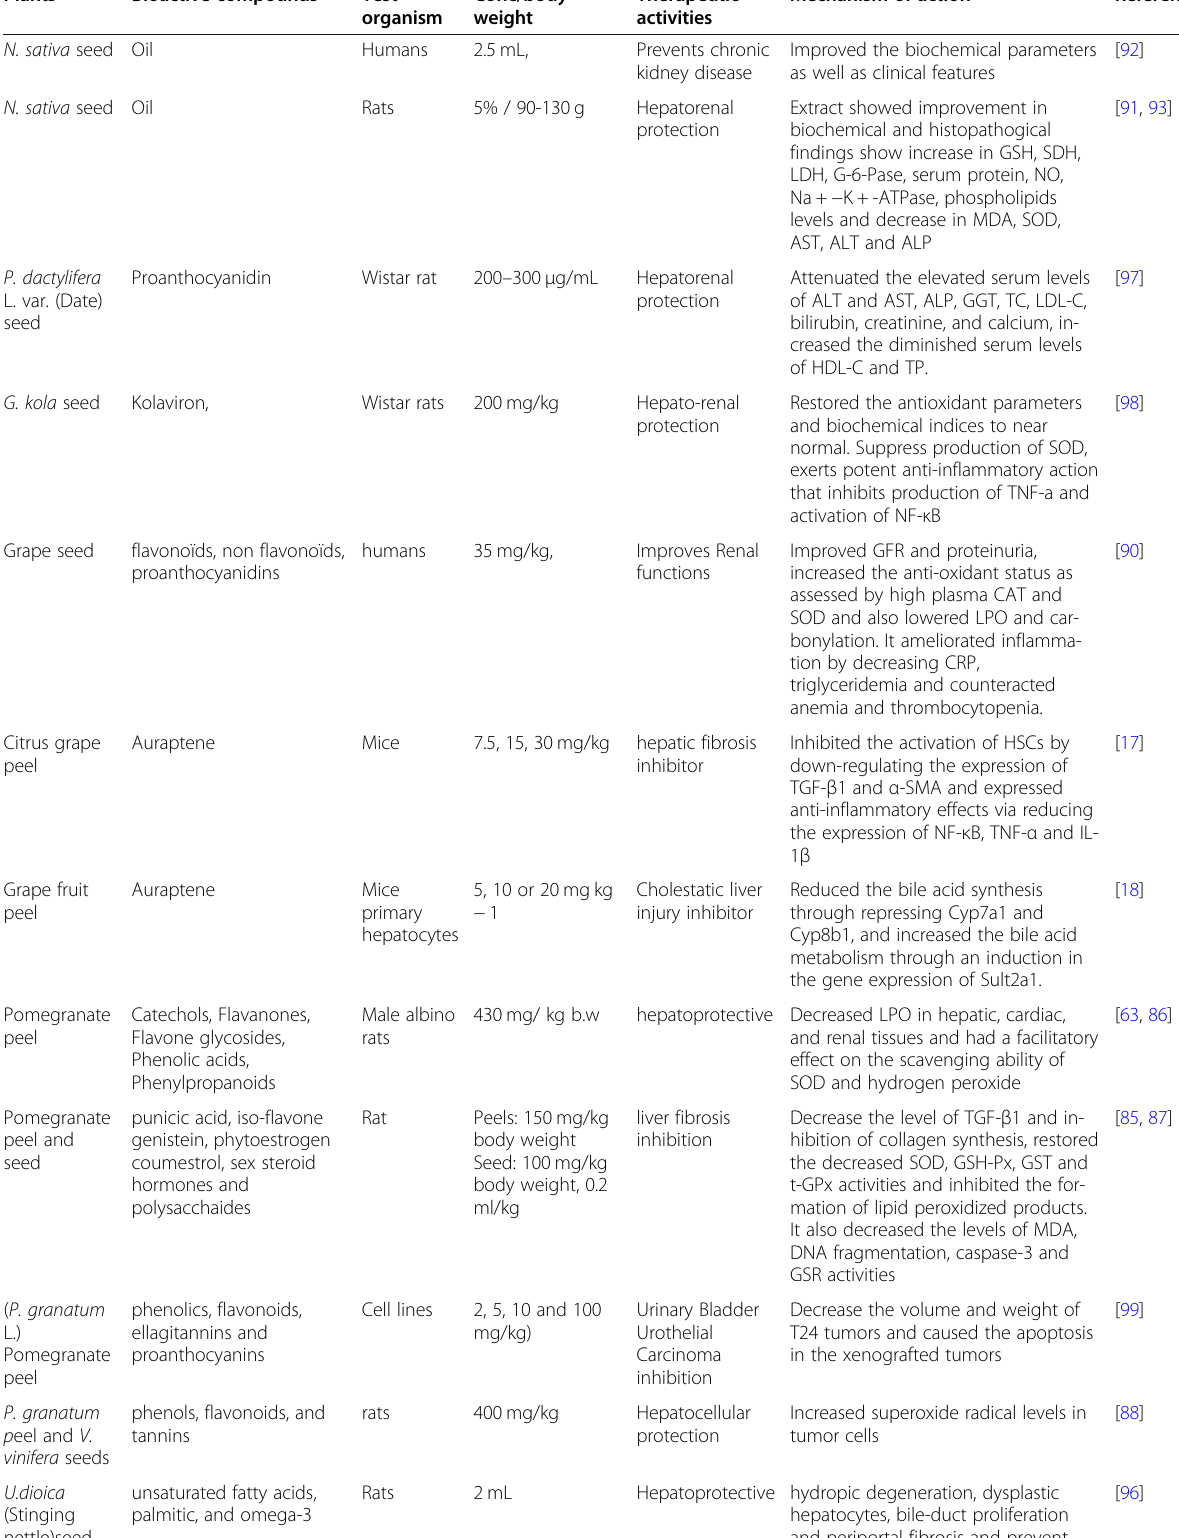
Table 5 Hepatorenal protection properties of some peels and seed